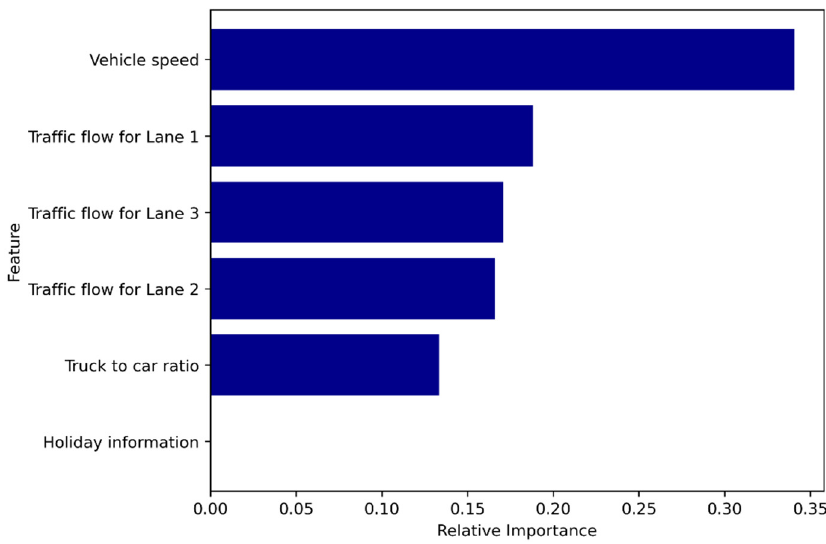
Figure 4. Feature relative importance in Nantung direction. Figure 6. Feature relative importance in Nantung direction. Figure 6. Feature relative importance in Nantung direction.